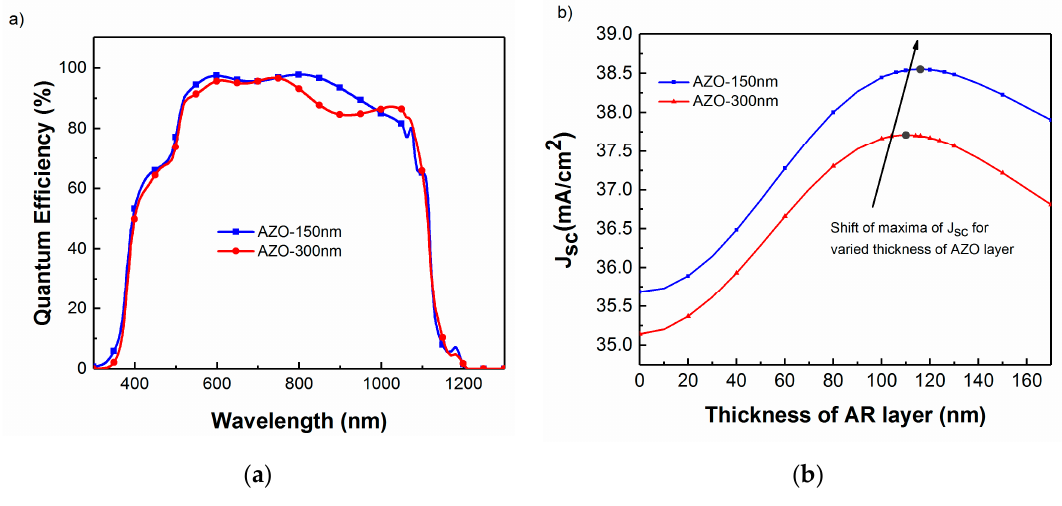
Figure 13. ( a ) Simulated QE for varied AZO layer thickness with a fixed 110 nm MgF 2 AR layer. ( b ) Simulated J SC as a function of MgF 2 thickness for various AZO layer thickness.